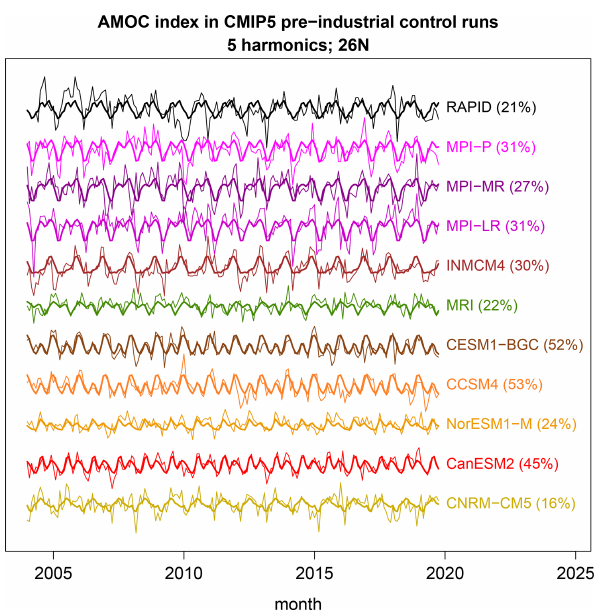
Figure 2. Monthly time series of the maximum transport at 26 ◦ N (thin curves) from observations (RAPID; top, black curve) and CMIP5 models (colored curves, with model names at the right end). The thick curves show the best-fit annual cycle based on five annual harmonics. The percentages next to the names are the percent vari- ance explained by the annual cycle (i.e., the R 2 of the annual cycle). The annual cycle is computed by ordinary least squares without ac- counting for serial correlation. The time series have been offset rel- ative to each other by an additive